Question: Provide a one-line summary of what is displayed.
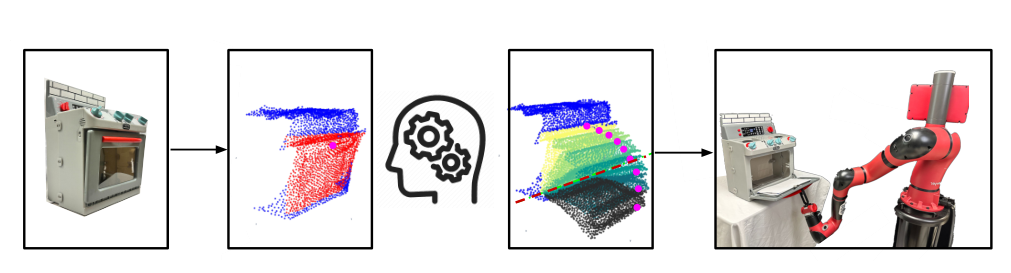
Answer: FlowBot++ in Action. The system first observes a point cloud observation of an articulated object and estimates the object’s Articulation Flow and Articulation Projection to infer the articulation axis. Then the inferred axis is used to output a smooth trajectory to actuate the object.